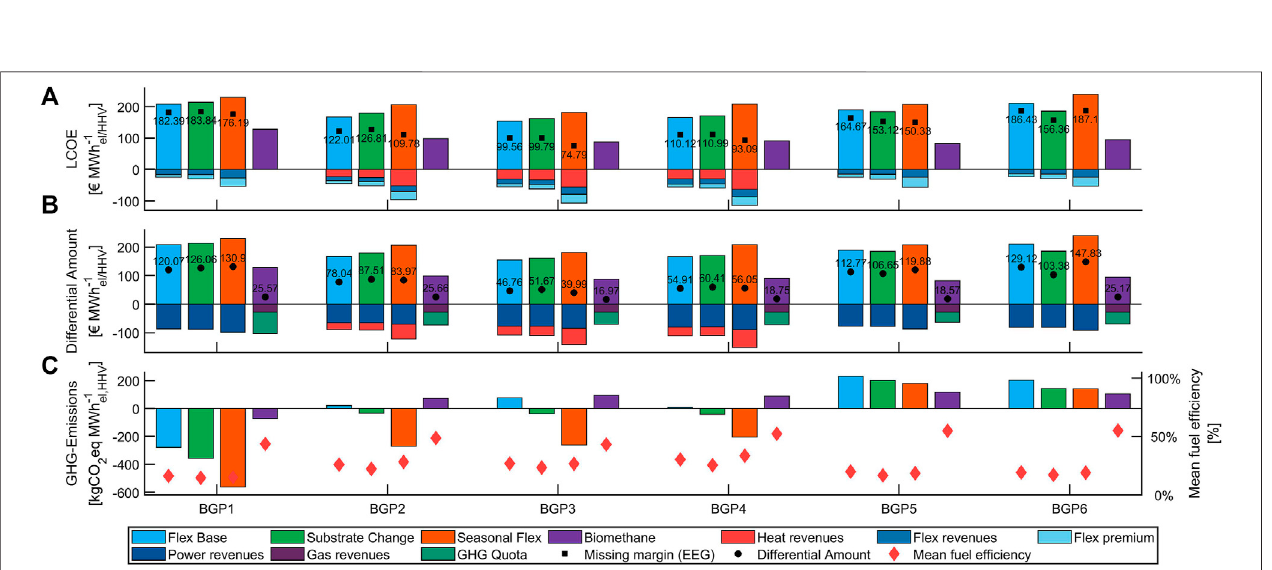
FIGURE4| KPIcomparisonoffollow-upconceptsfortherepresentativeBGPsintheREFscenario;BGP,Biogasplants;LCOE,Levelizedcostofenergy/electricity; GHG, Greenhouse